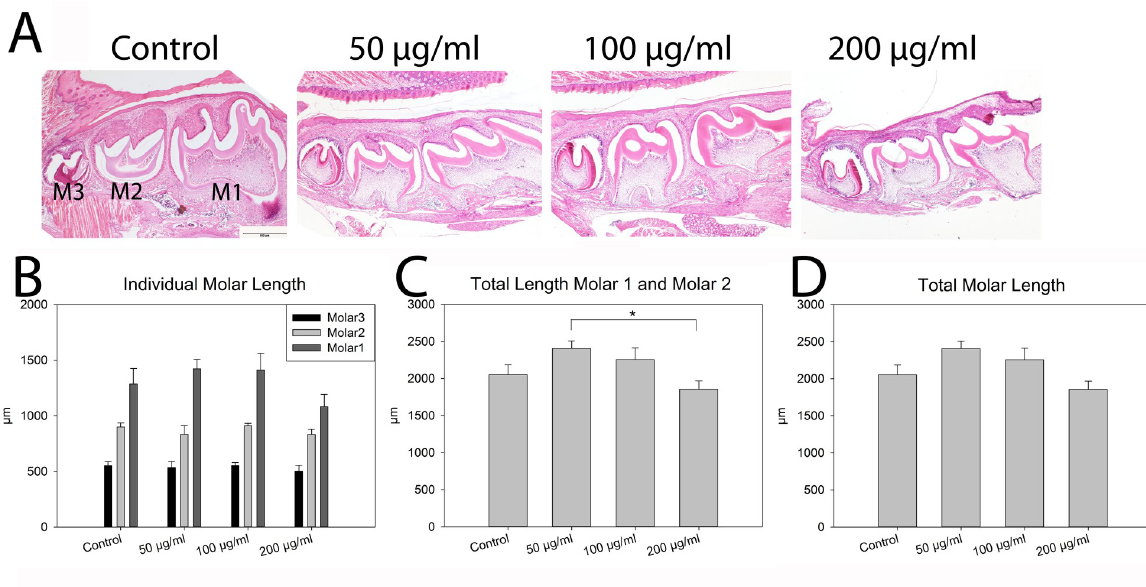
Fig 3. Histological analysis of mandibular molars. A) Representative hematoxylin and eosin stained sections of mandibular molars from individuals exposed to 0 μ g/ml (control), 50 μ g/ml (low), 100 μ g/ml (medium), or 200 μ g/ml (high) nicotine in utero . Molars 1–3 are marked M1, M2, M3 with tongue above for orientation. B) Histomorphometric analysis of molar length for M1, M2, M3 indicate no change with exposure. C) Length of erupted molars 1 and 2 together is reduced with the highest nicotine dose compared to the low dose however, the total molar length does not vary (D) . n = 4 per exposure Scale Bar = 500 μ m. � p <